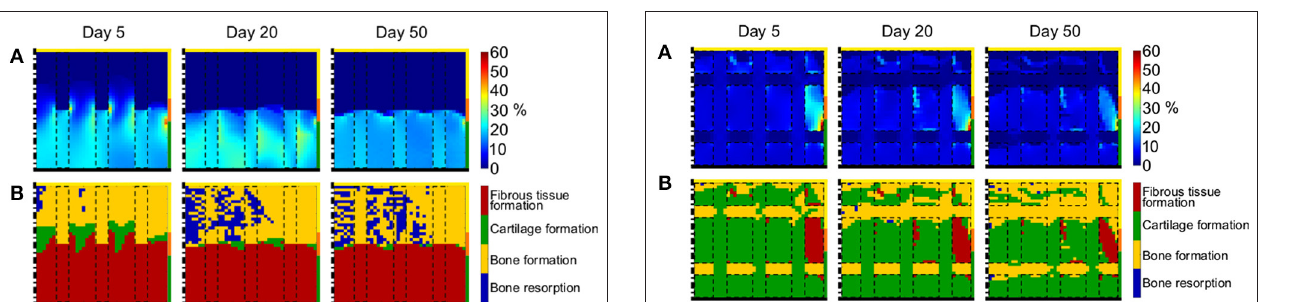
in the rest of the defect experiencing intermediate values of γ ( Figure 6F right). Fibrous tissue was found at the peripheral side only, where high values of γ were found. Interestingly, no bone resorption was observed.